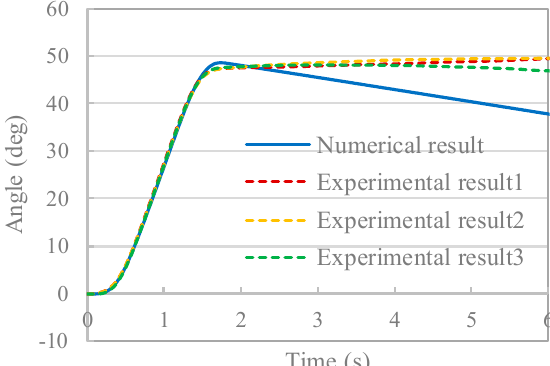
Machines 2018 , 6 , x FOR PEER REVIEW